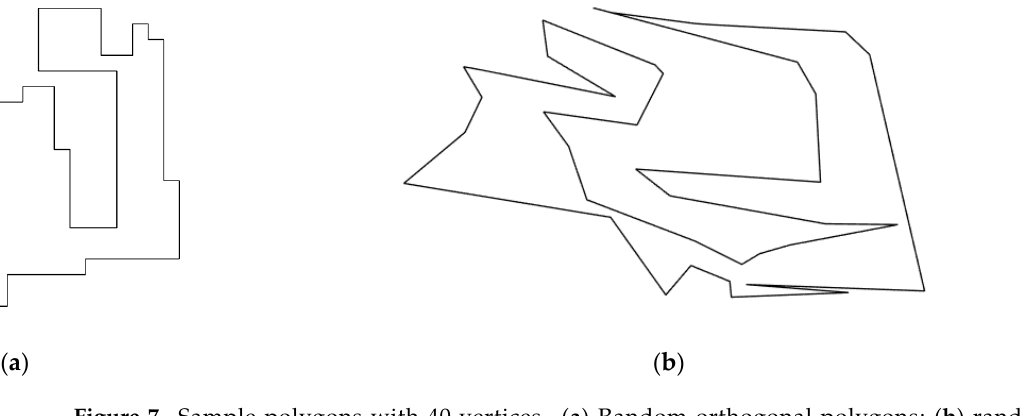
Figure 7. Sample polygons with 40 vertices. ( a ) Random orthogonal polygons; ( b ) random simple polygons.